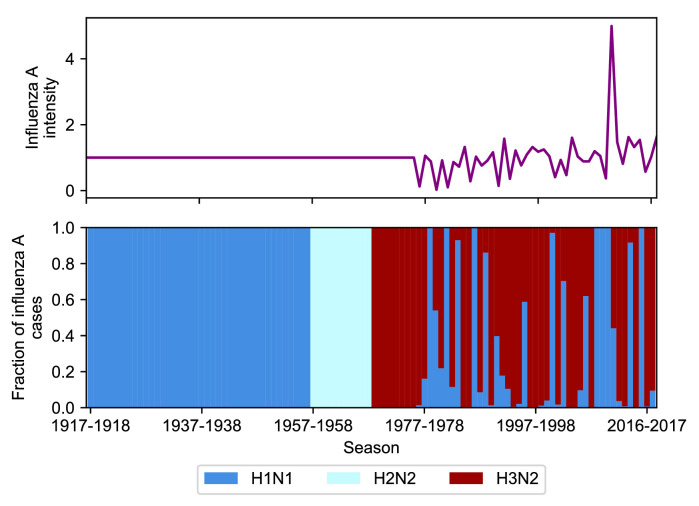
Intensity and subtype frequencies of influenza A.The intensity (top panel) and subtype frequencies (bottom panel) of influenza A seasons in the United States. Intensity is measured as the product of influenza-like illness (ILI) and the fraction of respiratory specimens testing positive for influenza A in national surveillance data (Appendix 1: ‘Seasonal intensity’). This is normalized to the average intensity value between 1977 and 2017–2018. Seasons before 1977 where United States ILI surveillance data are unavailable are assumed to have an intensity score of 1 (i.e., the average score over all other seasons). Subtype frequencies were obtained from national surveillance data before the 2007–2008 season and directly from the MESA studies afterwards.